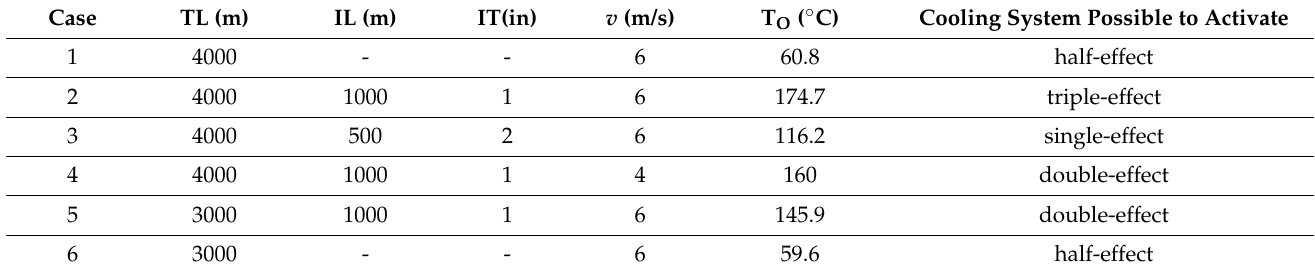
Table 2. Values considered for the simulations of the geothermal